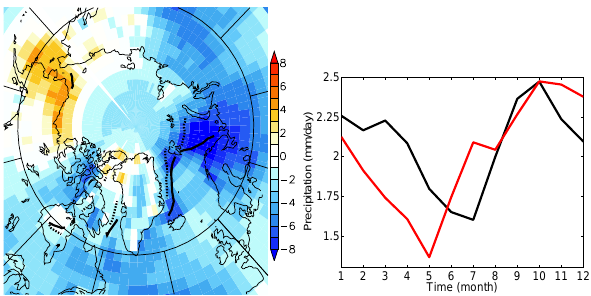
Fig. 1. Left: Difference in annual average surface air temperature, preindustrial control climate minus ERA-40 climatology, in ◦ C (colors). Contours show the annual average 50% sea ice edge for the simulation (solid) and ERA-40 (dotted). Right: Monthly average precipitation on land over Scandinavia (red box Fig. 4) for the IPSL CM4 preindustrial control experiment (black) and the ERA-40 climatology (red).